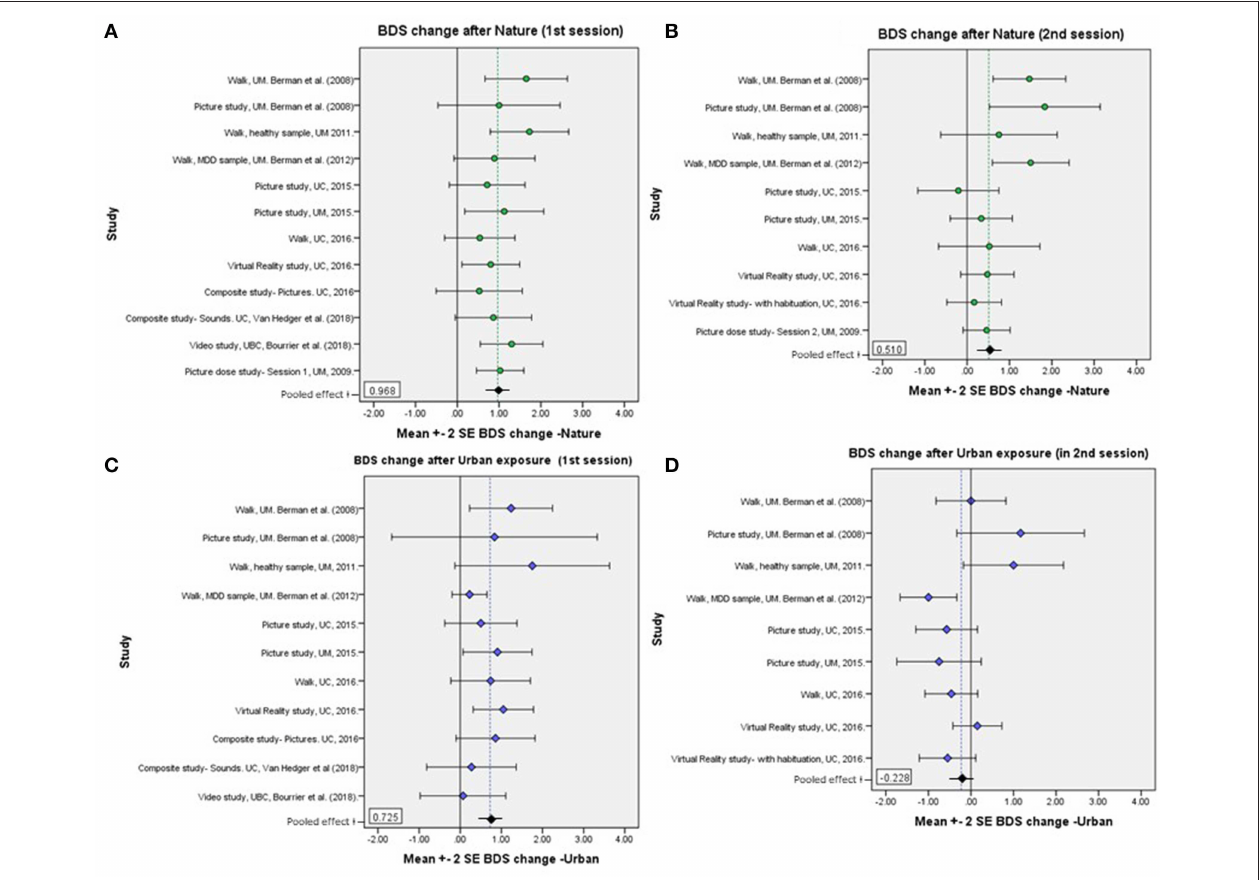
FIGURE 1 | (A–D) Mean BDS score changes pre- to post- nature vs. urban environment interactions, by order of environment conditions, for each study sample. (A) BDS change after nature, 1st sessions; (B) BDS change after nature, 2nd sessions; (C) BDS change after urban exposure, 1st sessions; (D) BDS change after urban exposures, 2nd sessions. The dotted reference lines represent the grand mean of all participants included in the respective plots/conditions. See results in Table 3